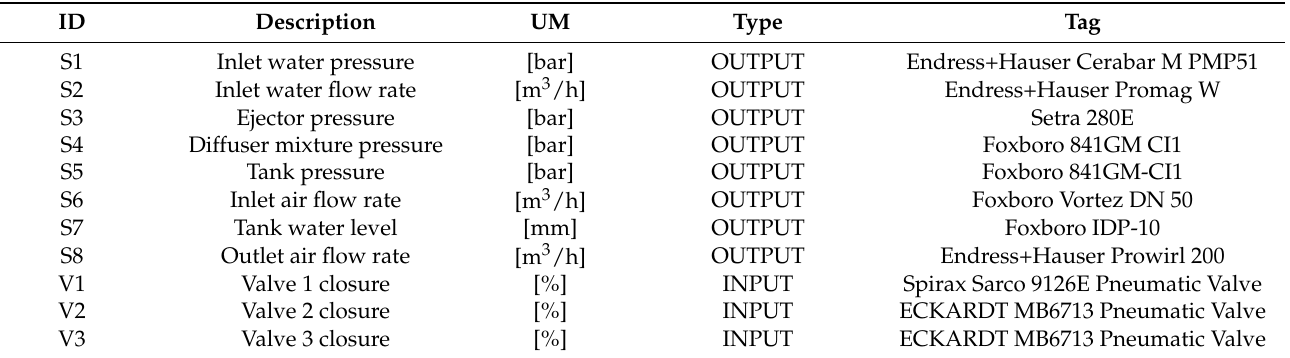
Table 2. Plant equipment characteristics.